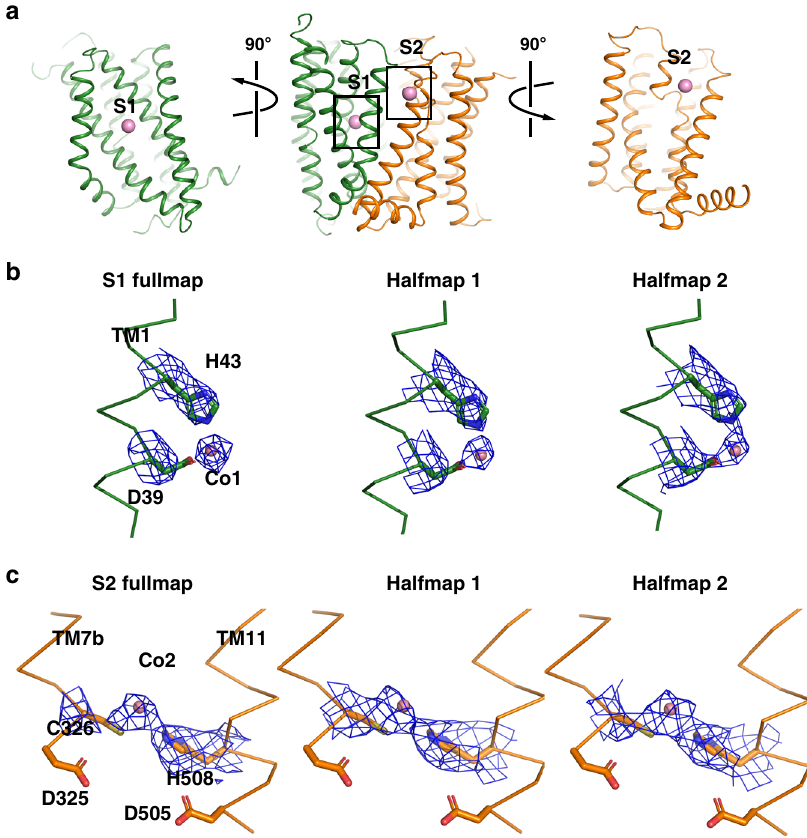
Fig. 3 Two ion binding sites in TsFpn. a TsFpn in cartoon representation is shown in three orientations with the locations of S1 and S2 marked by the bound Co 2 + (pink spheres). b Density map around S1 is shown as blue mesh. Part of the TM1 is shown as trace and the side chains of Asp39 and His43 are shown in stick. c Density map around S2 is shown as blue mesh. Part of the TM7 and 11 are shown as trace and the side chains of Asp325, Cys326, Asp505, and His508 are shown as